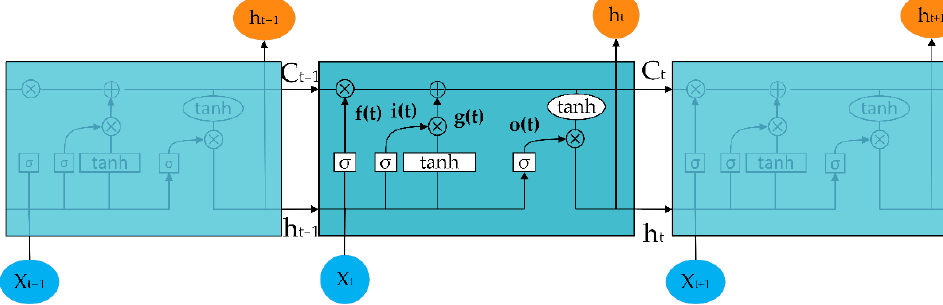
Figure 1. LSTM network structure.